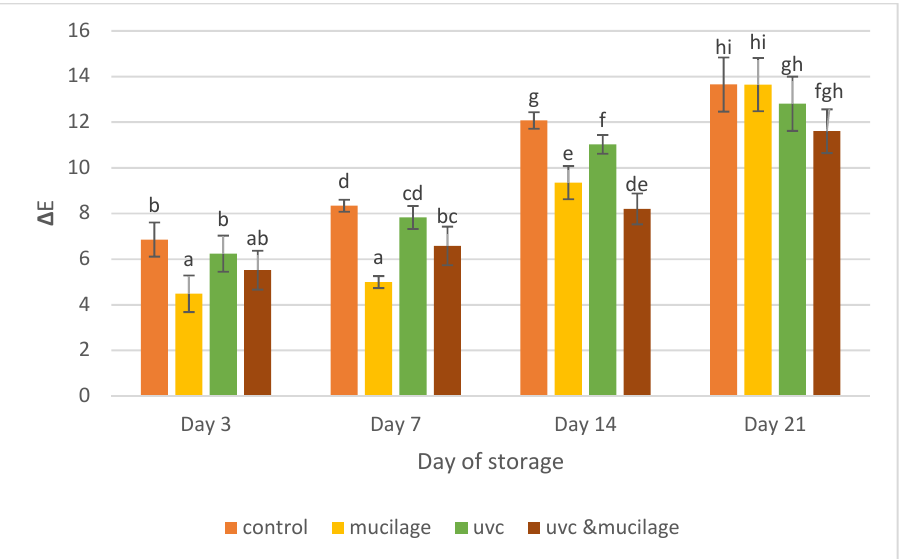
Figure 3. Effect of mucilage coating and UV-C on color. Values followed by different letters within the same column are significantly different ( p < 0.05) ( n = 12).